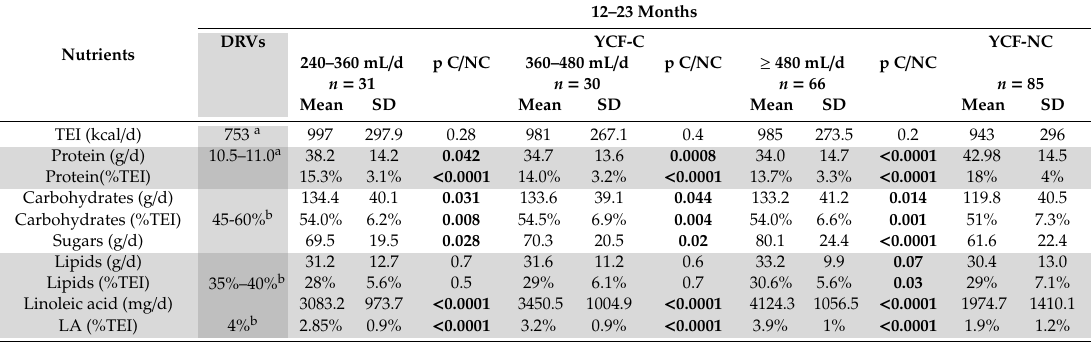
Table 7. Daily nutrient intake of YCF-C compared to YCF-NC aged 12_23 months, according to the intake of formula consumed and to EFSA DRVs, AR, or